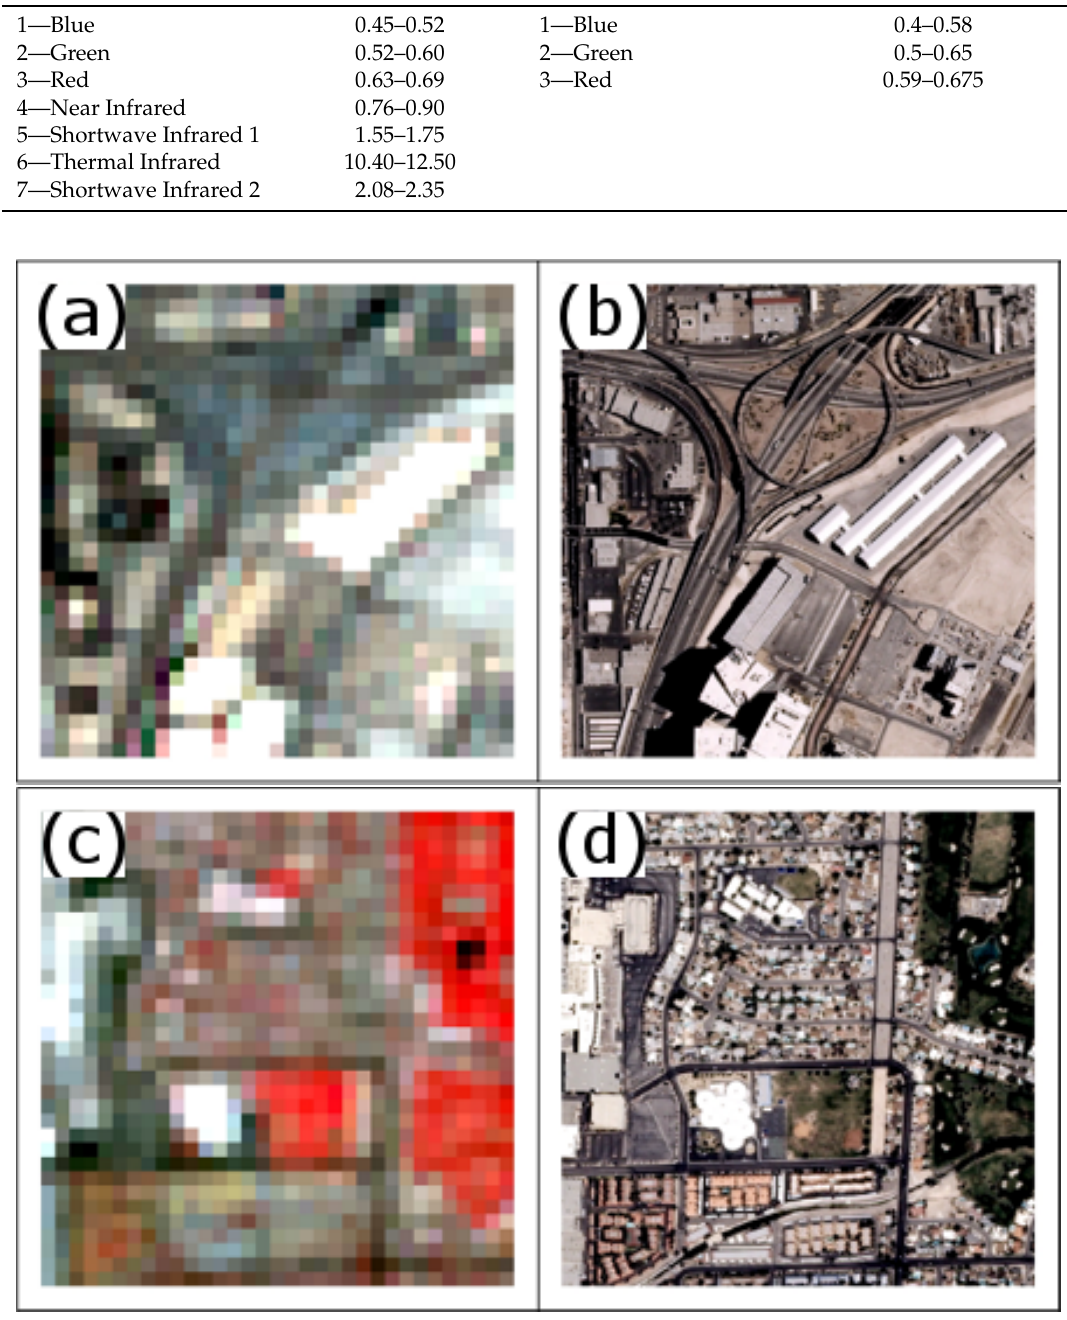
Figure 3. Comparison of ( a , c ) Landsat and ( b , d ) NAIP pixels at two sites including ( a , b ) a road network and ( c , d ) residential